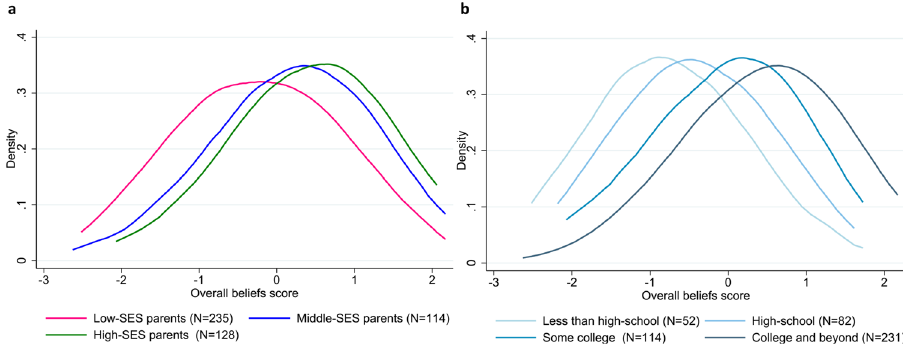
Fig. 1 Disparities in parents ’ beliefs about how parental investments affect child skill formation. a Kernel density estimation by socioeconomic status (SES). b Kernel density estimation by education only. Individual data points used for the estimation are provided as a Source Data fi